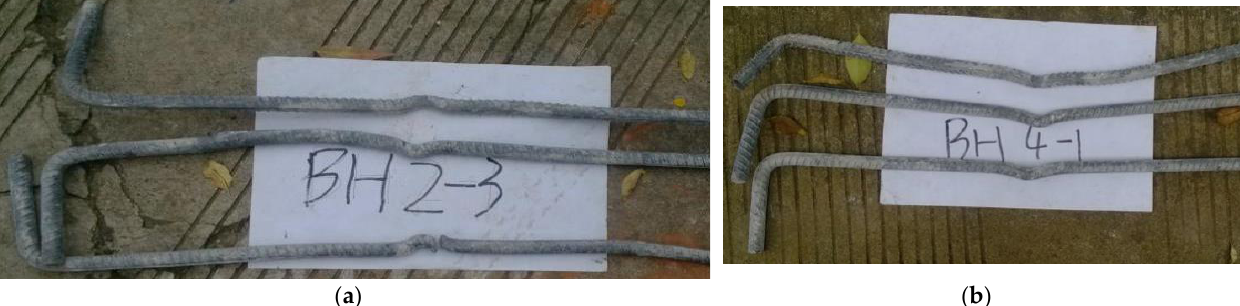
Figure 10. Rib plate and reinforcement of BH 2-3 and BH 4-1 specimens after the test: ( a ) Deformation form of reinforcement of BH 2-3; ( b ) Deformation form of reinforcement of BH 4-1.